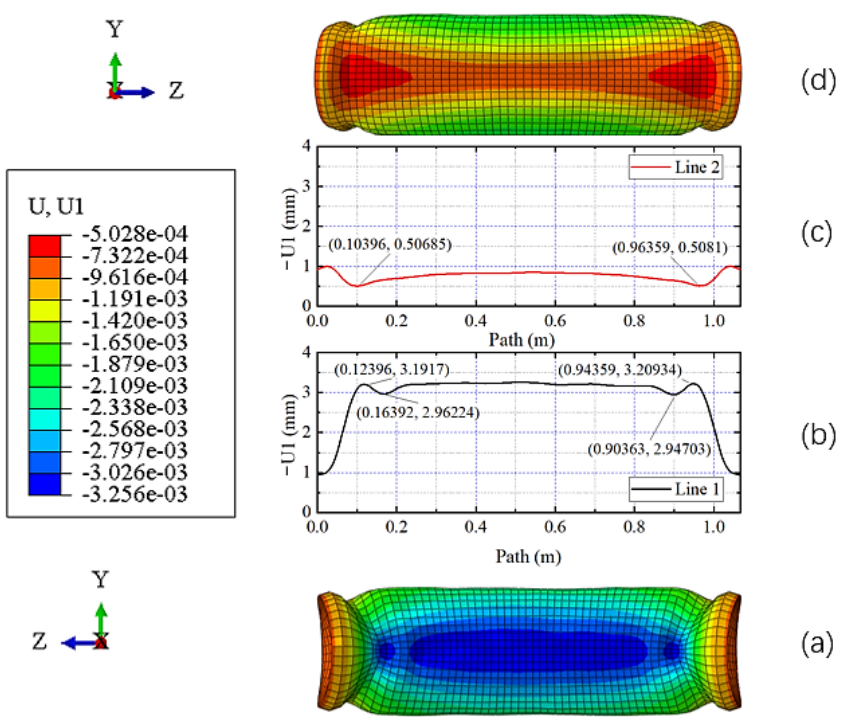
Figure 10. Displacement distribution diagram.